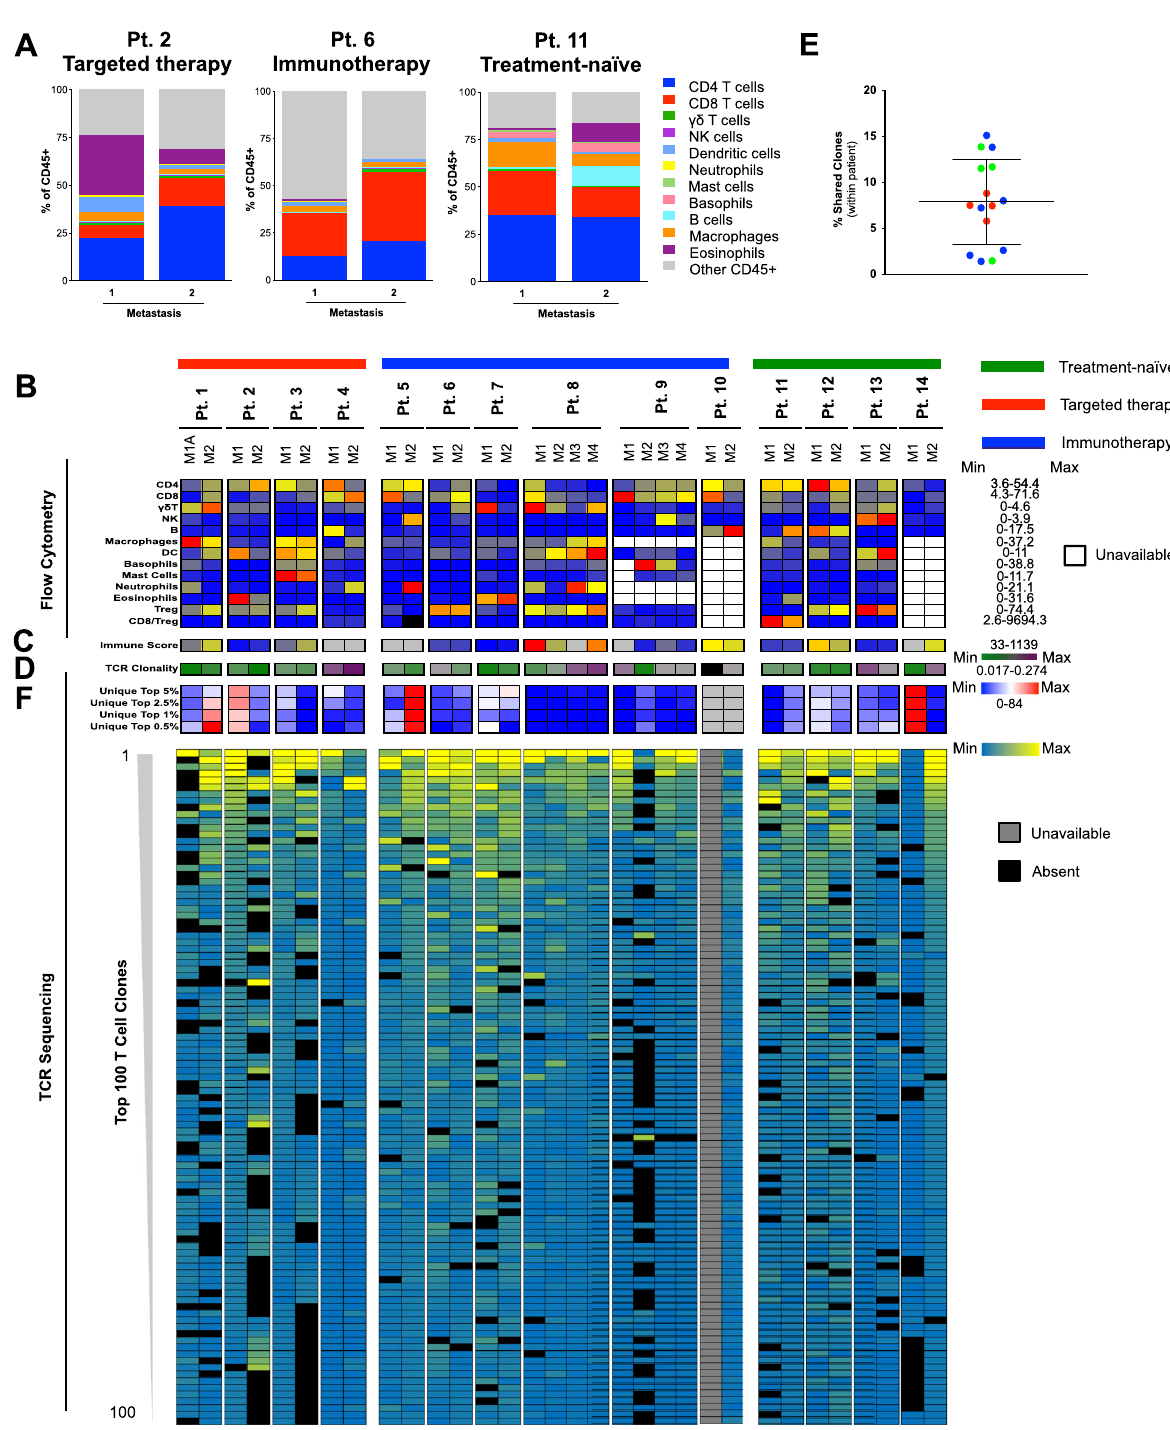
Fig. 3 Immune heterogeneity in synchronous melanoma metastases. a Flow cytometry demonstrating the relative contribution of each immune cell subset as a percentage of total CD45 + cells within synchronous metastases in a representative targeted therapy, immune checkpoint blockade, and treatment-naïve patient. b Aggregate fl ow cytometric pro fi ling data for all targeted therapy, immune checkpoint blockade, and treatment-naïve patients. c Immune score as calculated from gene expression pro fi ling data. d Aggregate data showing TCR clonality in each metastasis. e Aggregate TCR sequencing data showing the percent of shared T cells detected in synchronous metastases within each patient as a % of total T cell clones. Center value represents mean and error bar represents SD. f Aggregate TCR sequencing data showing unique T cell clones within the top 5, 2.5, 1, 0.5% and 100 most prevalent T cell clones per